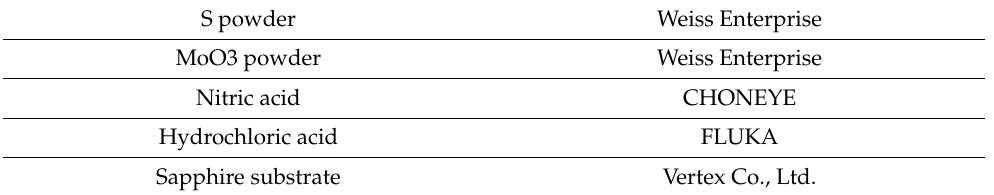
Table 1. List of substrates, organic solvents, gases, and chemicals used for MoS 2 . S